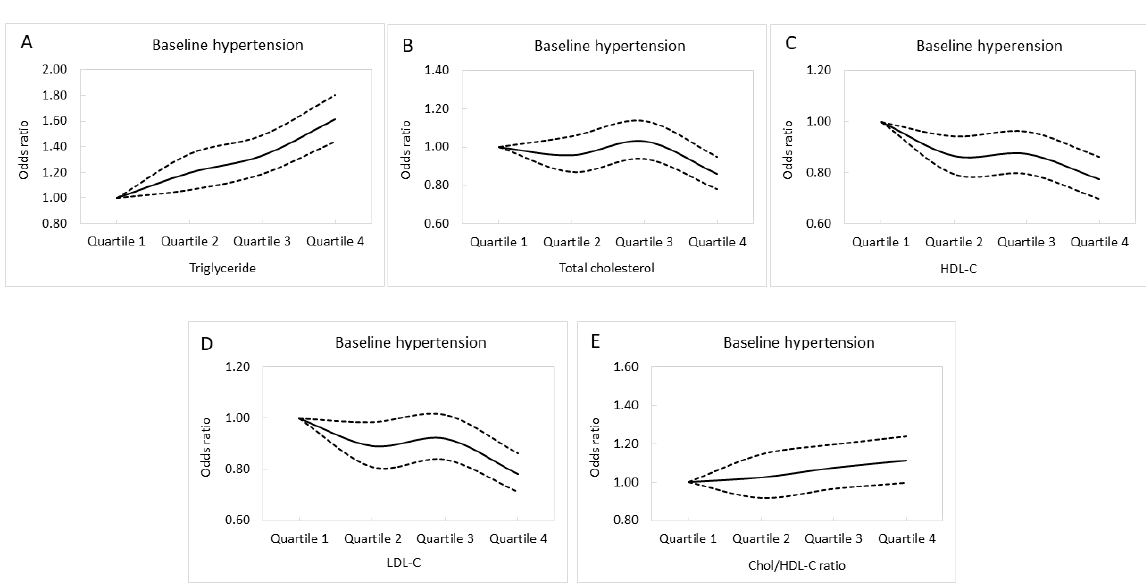
Figure 2. Adjusted baseline hypertension curves for the triglyceride ( A ), total cholesterol ( B ), HDL-C ( C ), LDL-C ( D ), and Chol/HDL-C ( E ) quartiles. Table 2. Associations of lipid profile quartiles with baseline hypertension according to logistic re- gression analysis for the whole cohort ( n = 26,965).